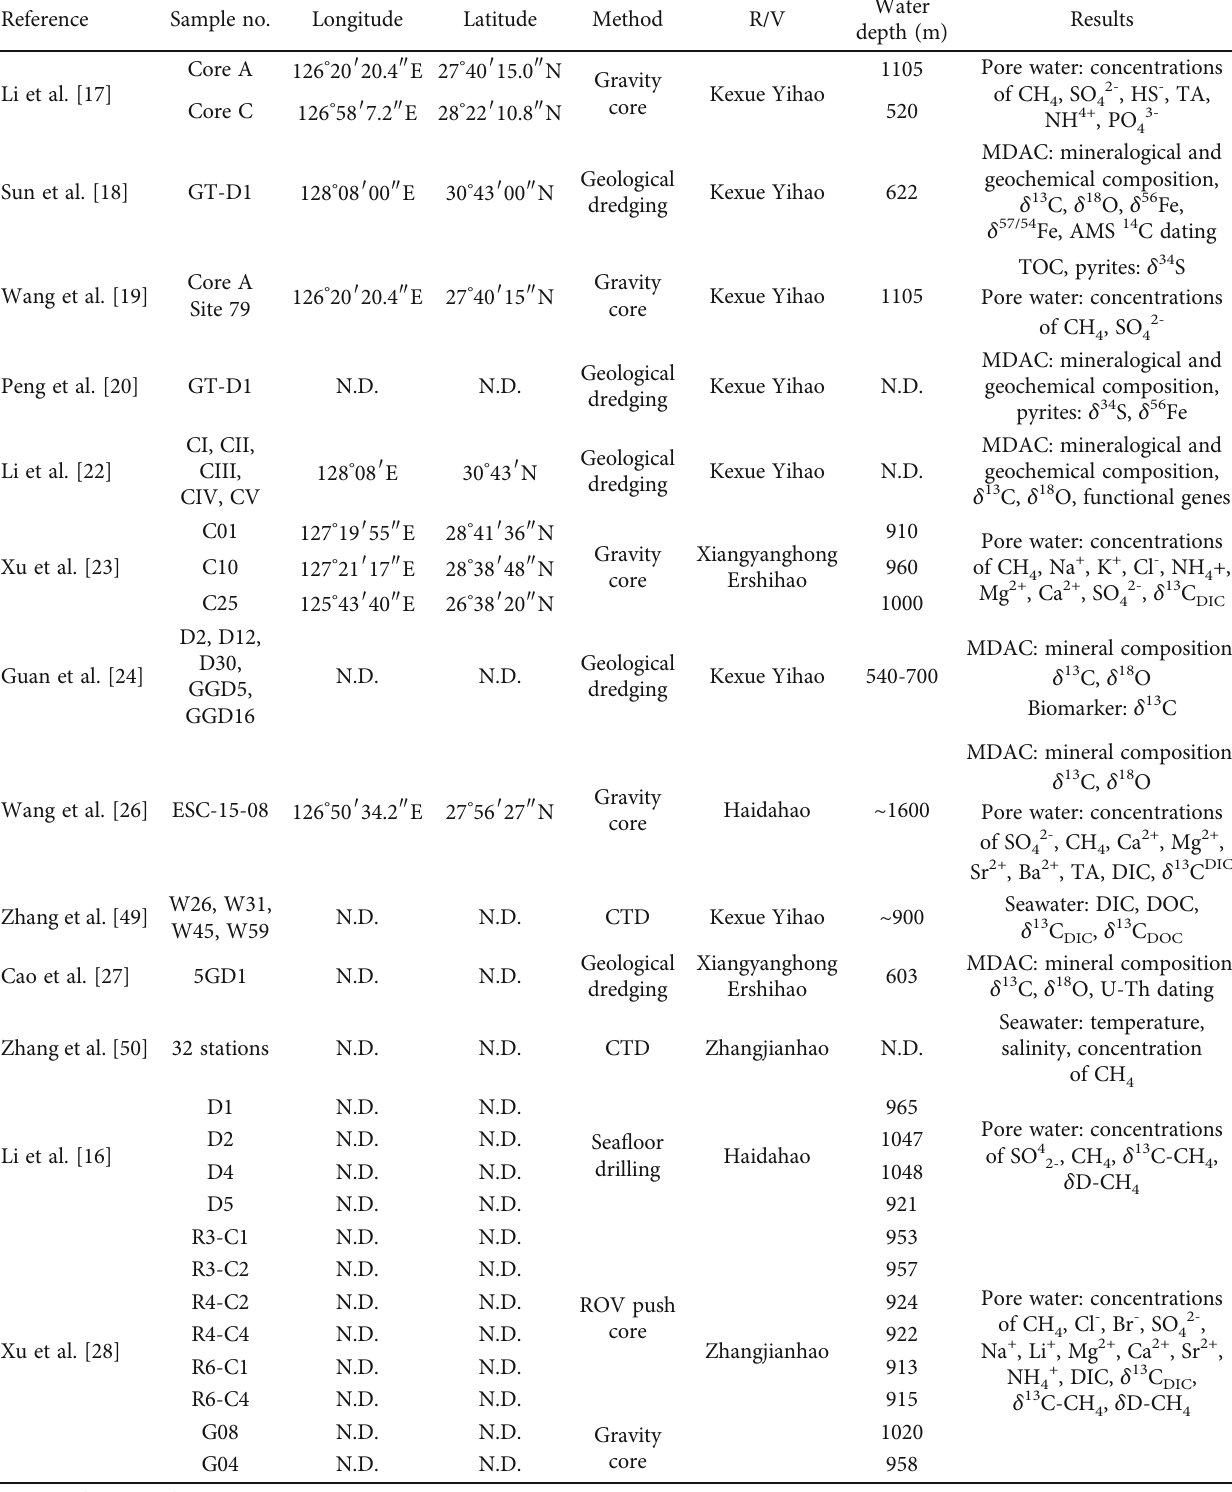
Table 2: Results of geochemical analysis associated with gas seeps in the Okinawa Trough. Reference Sample